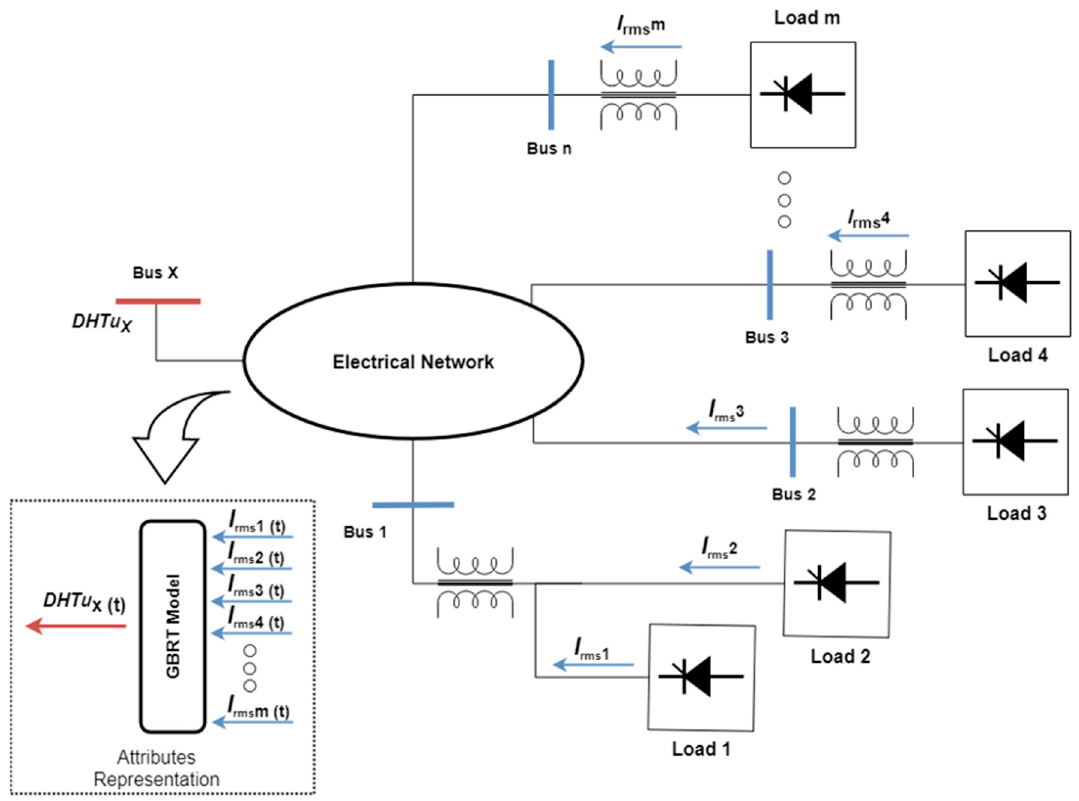
Figure 1. Characterization of the problem of identifying the contribution of multiple harmonic sources in THDu at a point of interest in the power grid. Adapted from [23].